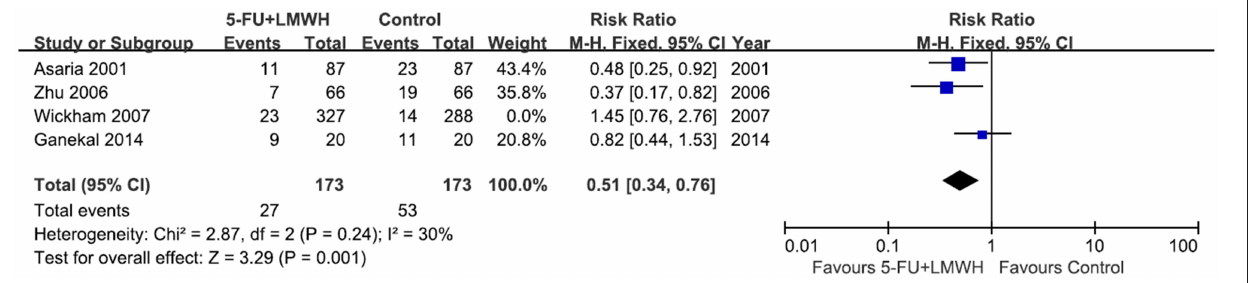
in any subgroup, as indicated by the P values of >